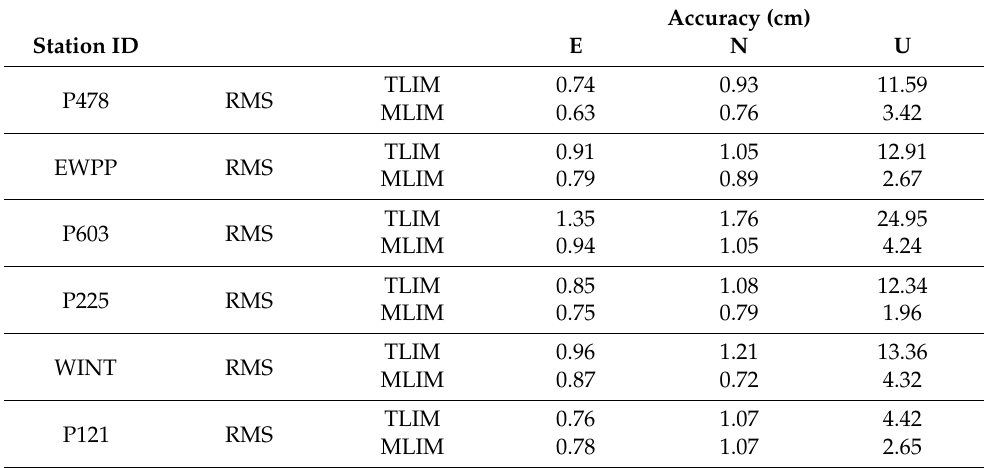
Table 3. Positioning RMS statistical results of each rover station in Dataset One.